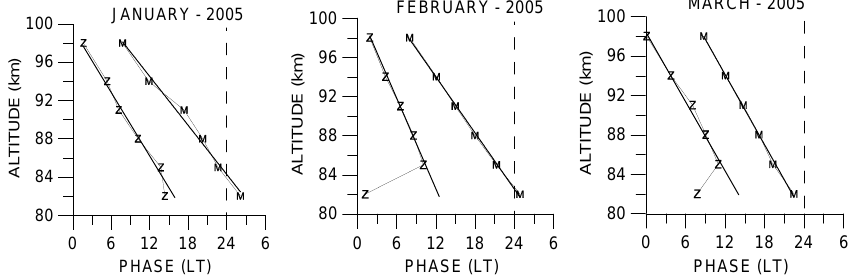
Fig. 6. Phase of zonal ( Z ) and meridional ( M ) diurnal tide from January 2005 to March 2005. The thick lines indicate the best fit used to calculate the vertical wavelength.